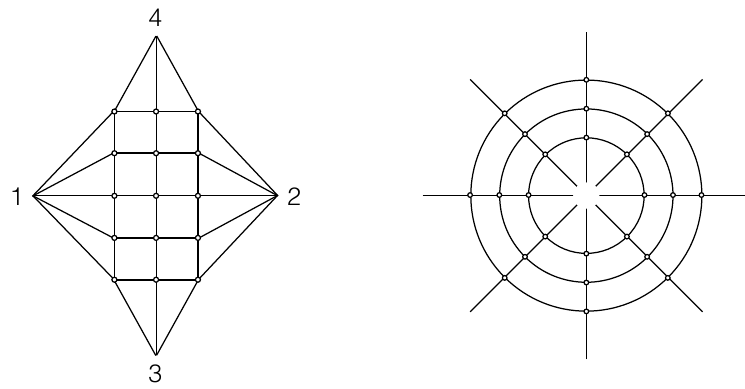
Figure 1 . Specimens of planar fishnet graphs in position space with different boundary conditions. Bulk points stand for quartic integration points, R d 4 x/π 2 , while edges are massless propagators, 1 / ( x − y ) 2 . For the fishnet four-point functions considered in this paper, the m vertical and n horizontal external legs end on four fixed spacetime points x 1 , 2 , 3 , 4 , as shown in the left panel ( m lines end on x 3 , 4 ; n lines end on x 1 , 2 ). In the right panel, we show an m -by- n fishnet graph with periodic boundary conditions in the angular direction. Such graphs are expected to scale as ∼ g − 2 mn when m, n → ∞ , with g c a numerical constant [20]. The four-point function considered in c this paper (left panel) scales differently, with a free energy per vertex that depends on the aspect ratio k = n/m